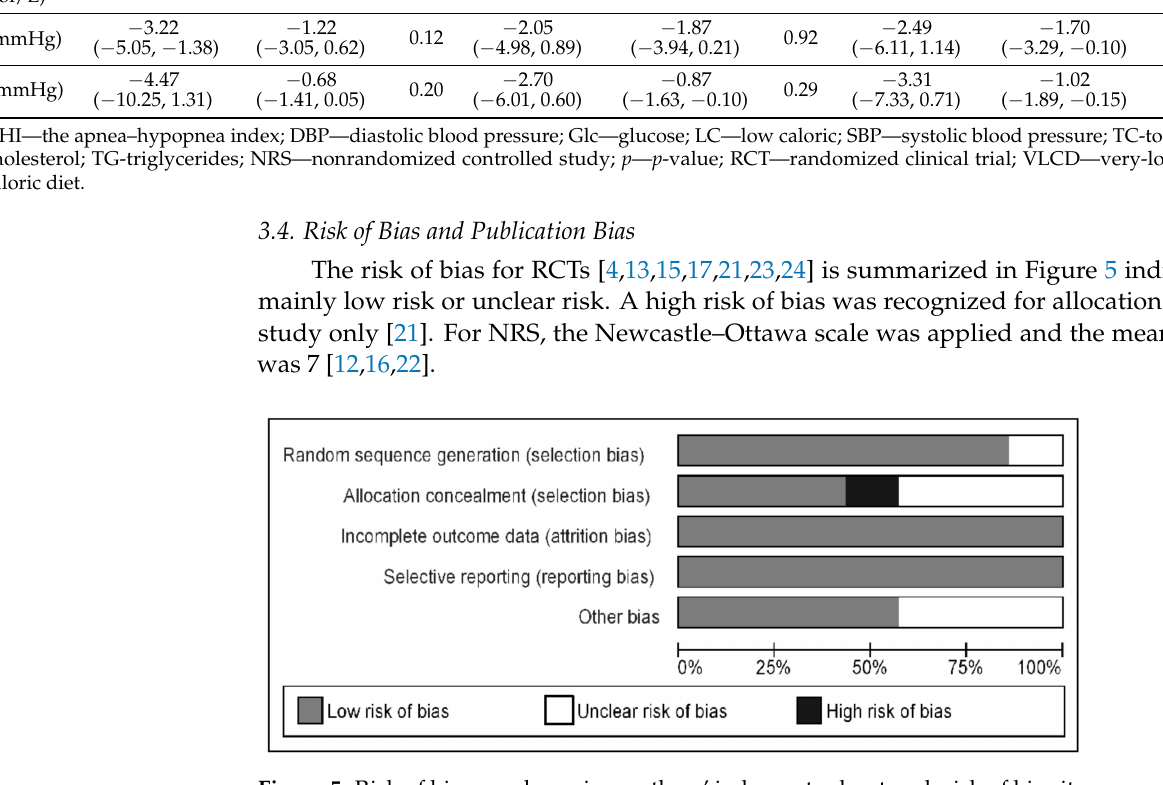
Figure 5. Risk of bias graph: review authors’ judgments about each risk of bias item presented as percentages across all included